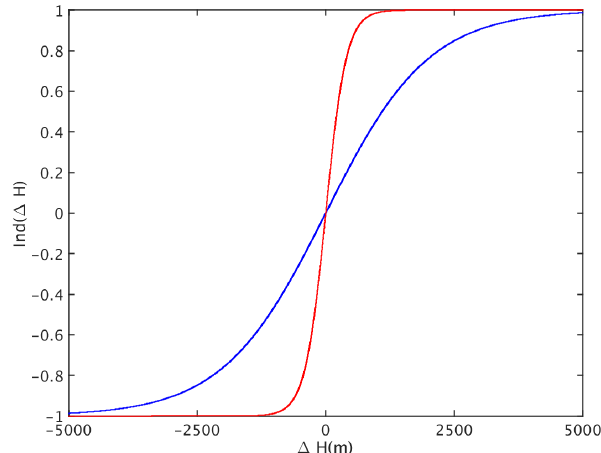
Figure 2. Sigmoid transformation: centroid derivation (blue) and pixels assignment